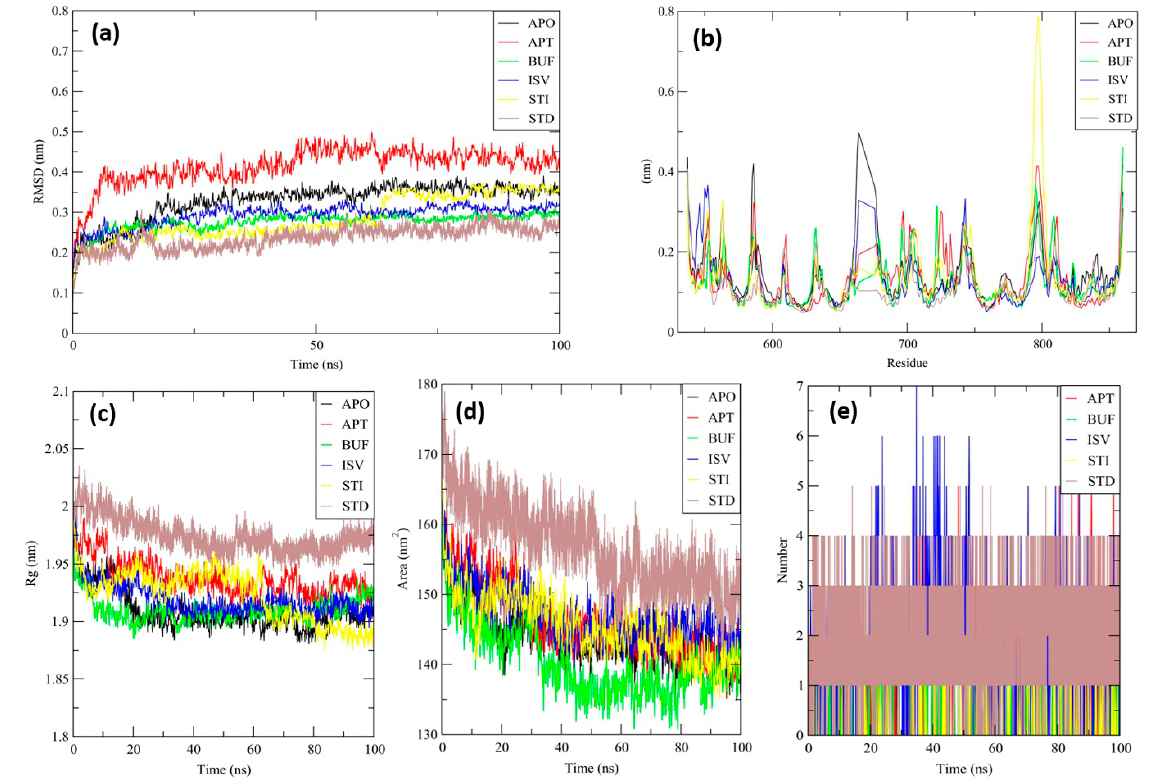
Figure 6. RMSD study plot for 100-ns MD simulation of PDE5-APO (Black), PDE5-BUF (Green), PDE5-STI (Yellow), PDE5-ISV (Blue), PDE5-APT (Red), and PDE5-STD drug sildenafil (Brown) ( a ). RMSF study plot for 100-ns MD simulation of PDE5-APO (Black), PDE5-BUF (Green), PDE5-STI (Yellow), PDE5-ISV (Blue), PDE5-APT (Red), and PDE5-STD drug sildenafil (Brown) ( b ). Radius of gyration study plot for 100-ns MD simulation of PDE5-APO (Black), PDE5-BUF (Green), PDE5-STI (Yellow), PDE5-ISV (Blue), PDE5-APT (Red), and PDE5-STD drug sildenafil (Brown) ( c ). Solvent accessible surface area study plot for 100-ns MD simulation of PDE5-APO (Black), PDE5-BUF (Green), PDE5-STI (Yellow), PDE5-ISV (Blue), PDE5-APT (Red), and PDE5-STD drug sildenafil (Brown) ( d ). Intermolecular hydrogen bonding study plot for 100-ns MD simulation of PDE5-APO (Black), PDE5-BUF (Green), PDE5-STI (Yellow), PDE5-ISV (Blue), PDE5-APT (Red), and PDE5-STD drug sildenafil (Brown) ( e ).